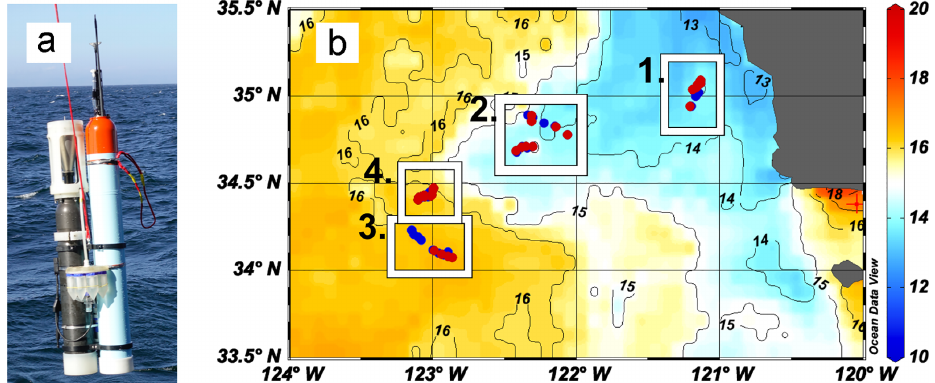
Figure 1. (a) CFE-Cal during deployment from R/V Revelle in 2017. The sampling system for particles is interfaced between the optical sedimentation recorder (a) and SOLO float (b) . (b) Map of CFE-Cal deployment and drift locations overlaying map of sea surface tem- perature ( ◦ C) for 10–17 June 2017 from NASA Ocean Color Aqua Modis 4km resolution (https://oceancolor.gsfc.nasa.gov/, last access: 26 August 2018). Blue dots within location boxes represent CFE-Cal 002 and red dots represent CFE-Cal 004